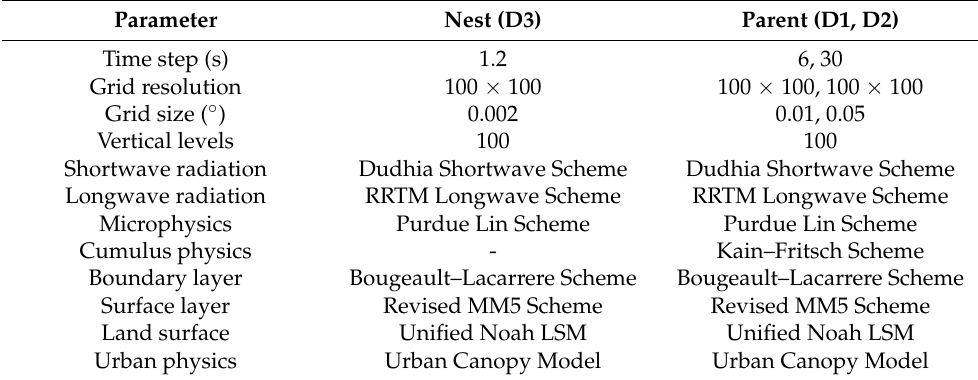
Table 1. WRF-ARW model configuration for nest and parent domains.